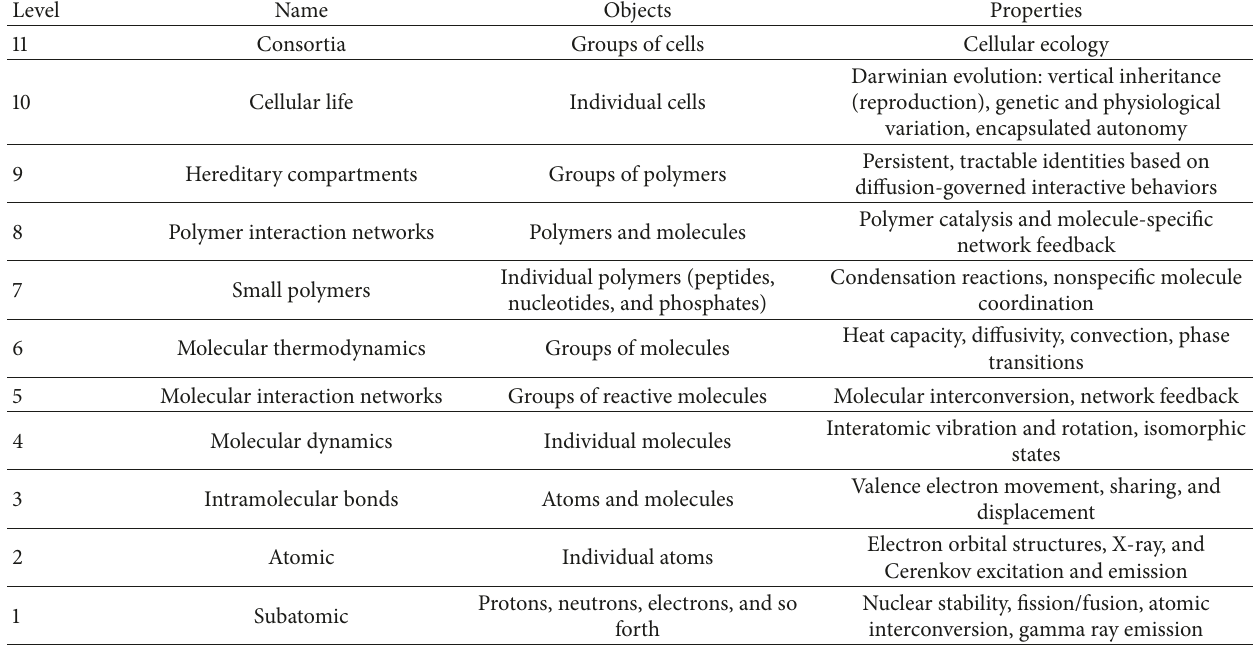
Table 2: The proposed hierarchy of nested objects relevant to comprehensive consideration of prebiotic evolution experiments.